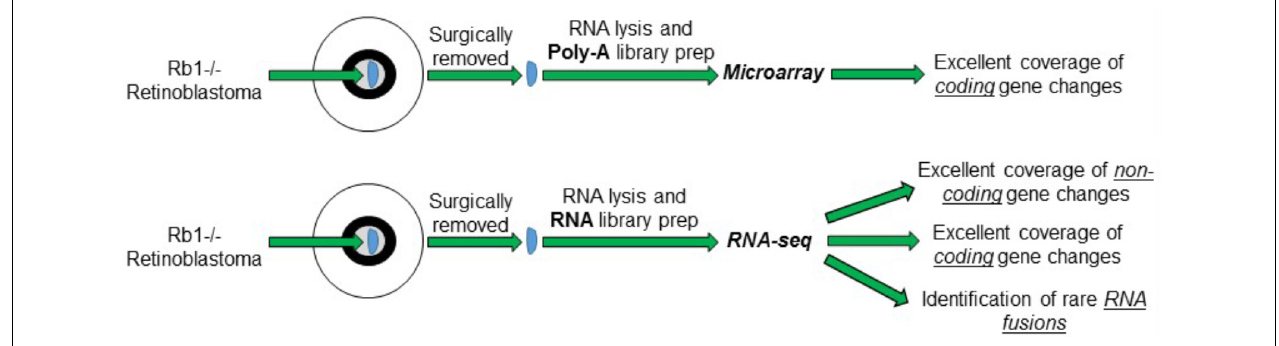
FIGURE 1 | Schematic of the different RNA measurements from Retinoblastoma tumors using conventional microarrays vs.